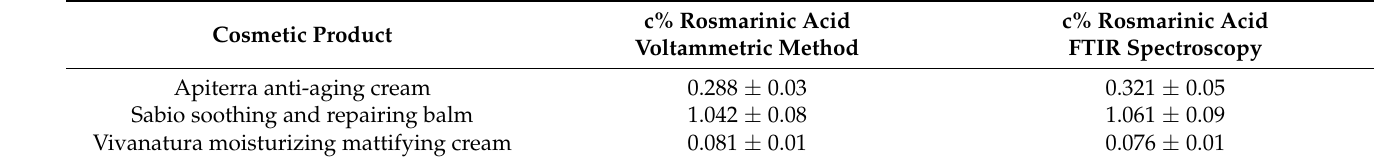
Table 3. Rosmarinic acid concentrations obtained from the two analysis methods used in this study.